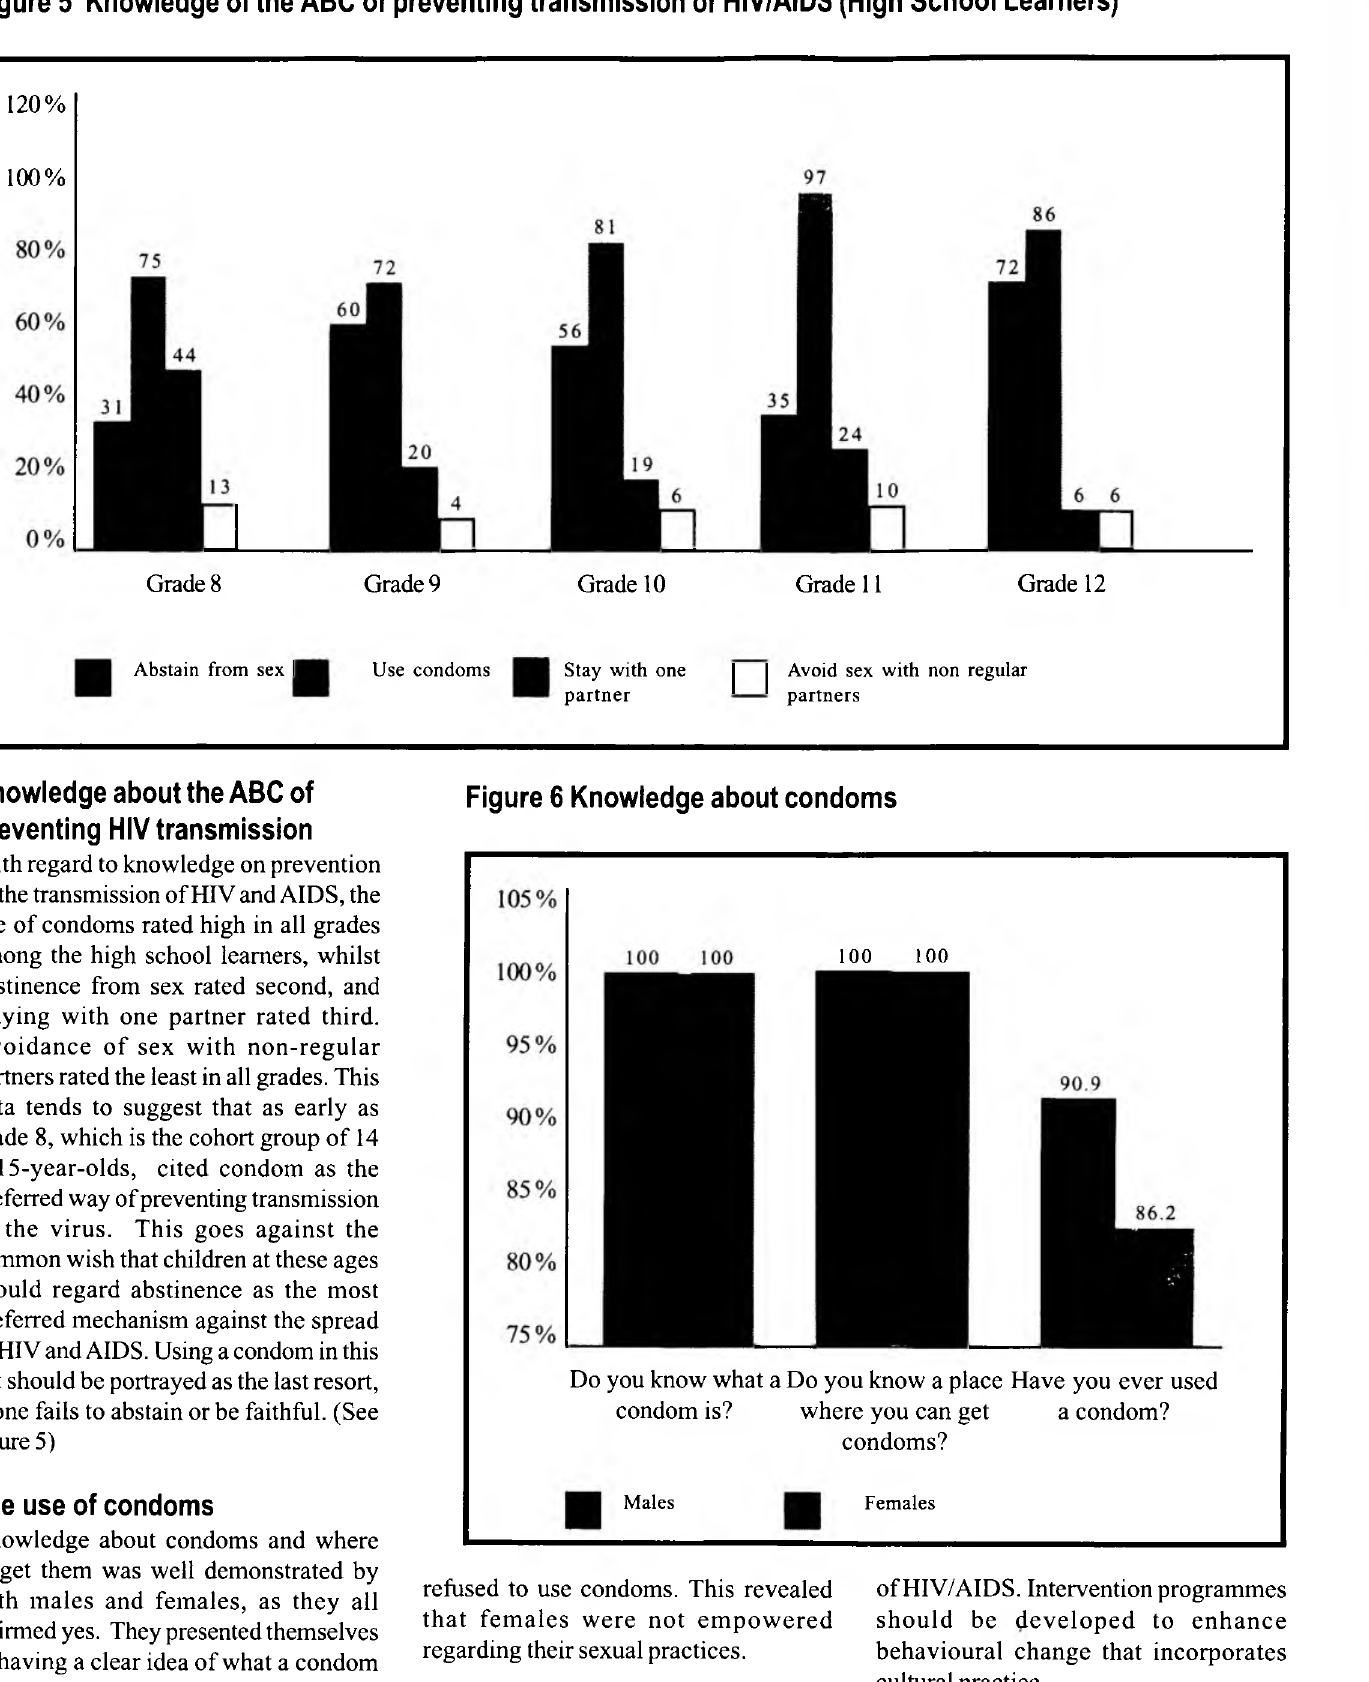
Figure 5 Knowledge of the ABC of preventing transmission of HIV/AIDS (High School